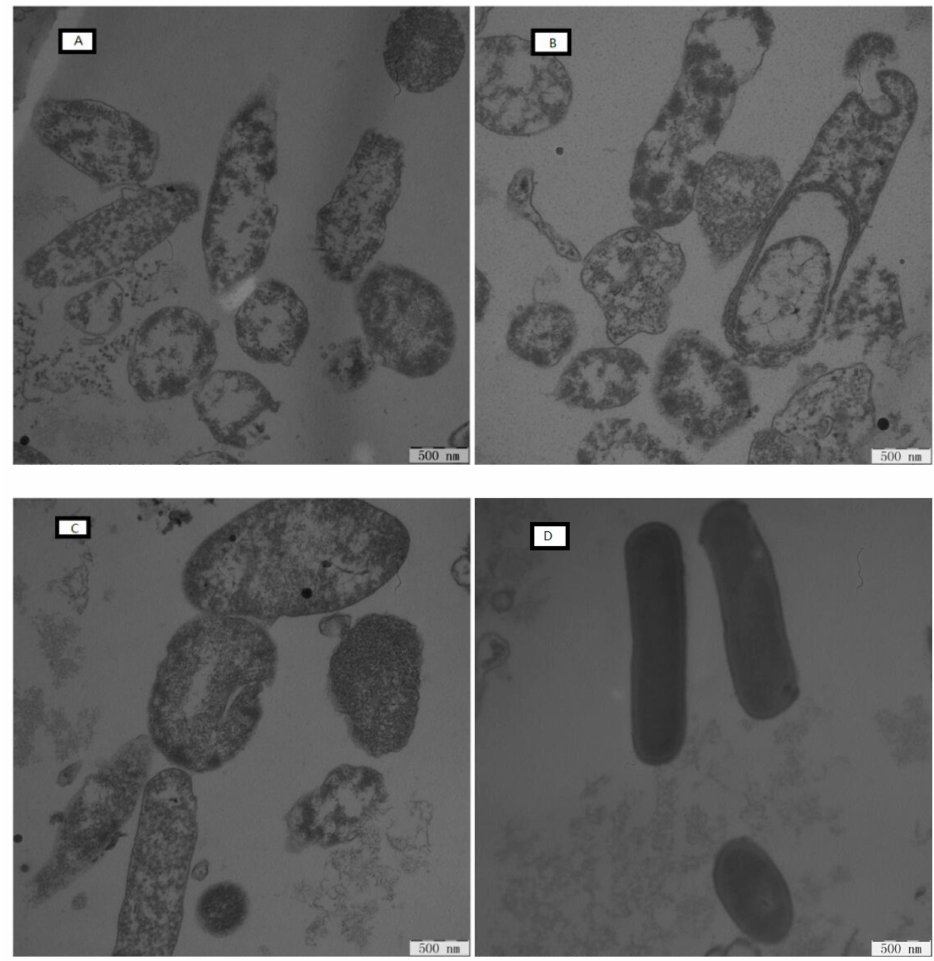
Figure 10. TEM micrographs of E. coli ATCC 25922 cells treated with the antimicrobial peptides. ( A ) KW-WK; ( B ) FP-PF; ( C ) FW-WF; ( D ) the control was processed without